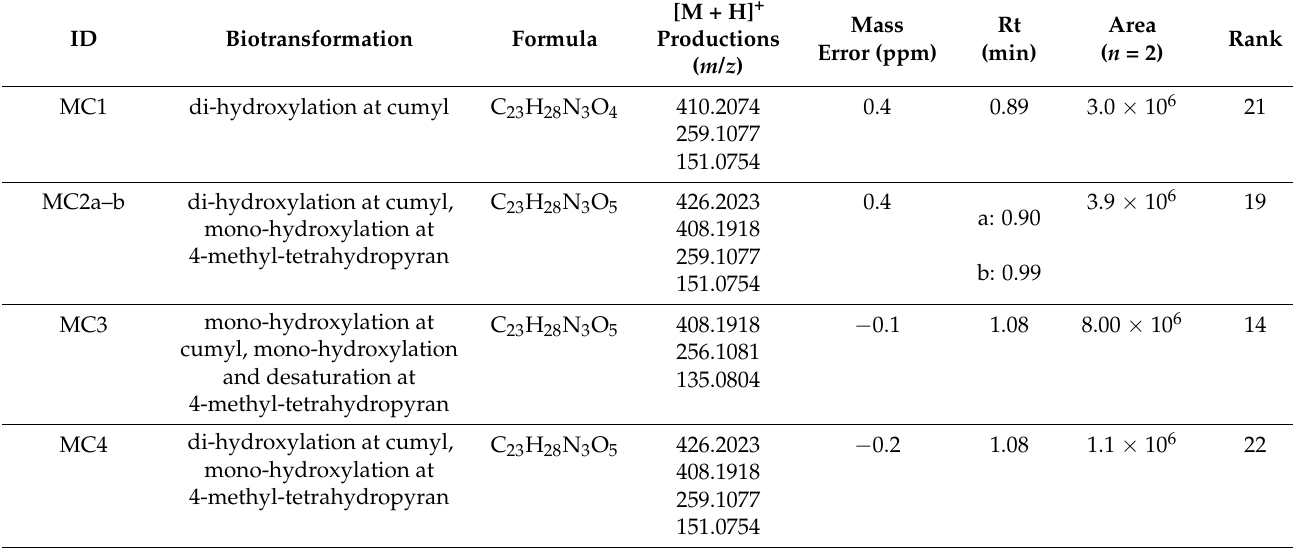
Figure 3. MS 2 spectra of CUMYL-THPINACA and its three most abundant metabolites (MC12, MC16, and MC22, shown in order of decreasing intensity). The proposed fragments leading to the respective signals are shown on the right. Table 1. Summary of all detected metabolites and the two detected artefacts of CUMYL-THPINACA (listed in the order of the observed retention times) with suggested biotransformations, chemical formulas, calculated [M + H] + of the parent ions with associated product ions ( m / z ), mass error (ppm), retention times (Rt), areas after 2 h of incubation using pHLM and ranking (highest to lowest abundancy).